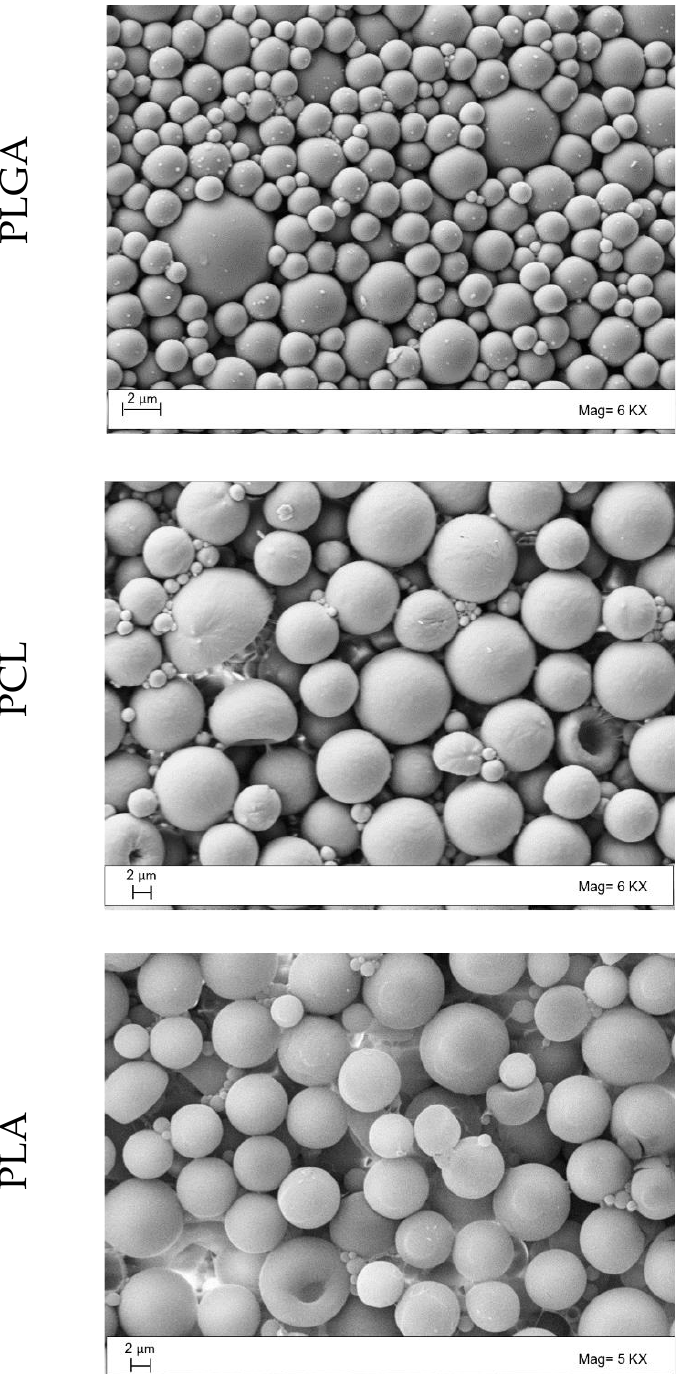
Figure 4. Representative HR FE-SEM images of the three different MPs. PLGA: poly(lactic- co -glycolic acid), PCL: poly(ε -caprolactone), PLA: poly(lactic acid).